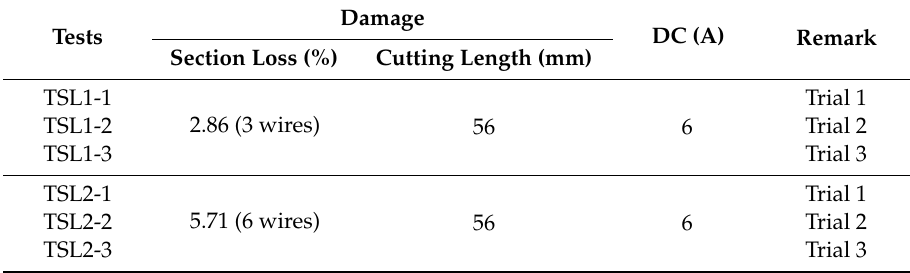
Table 1. Reduced section of the external tendon.